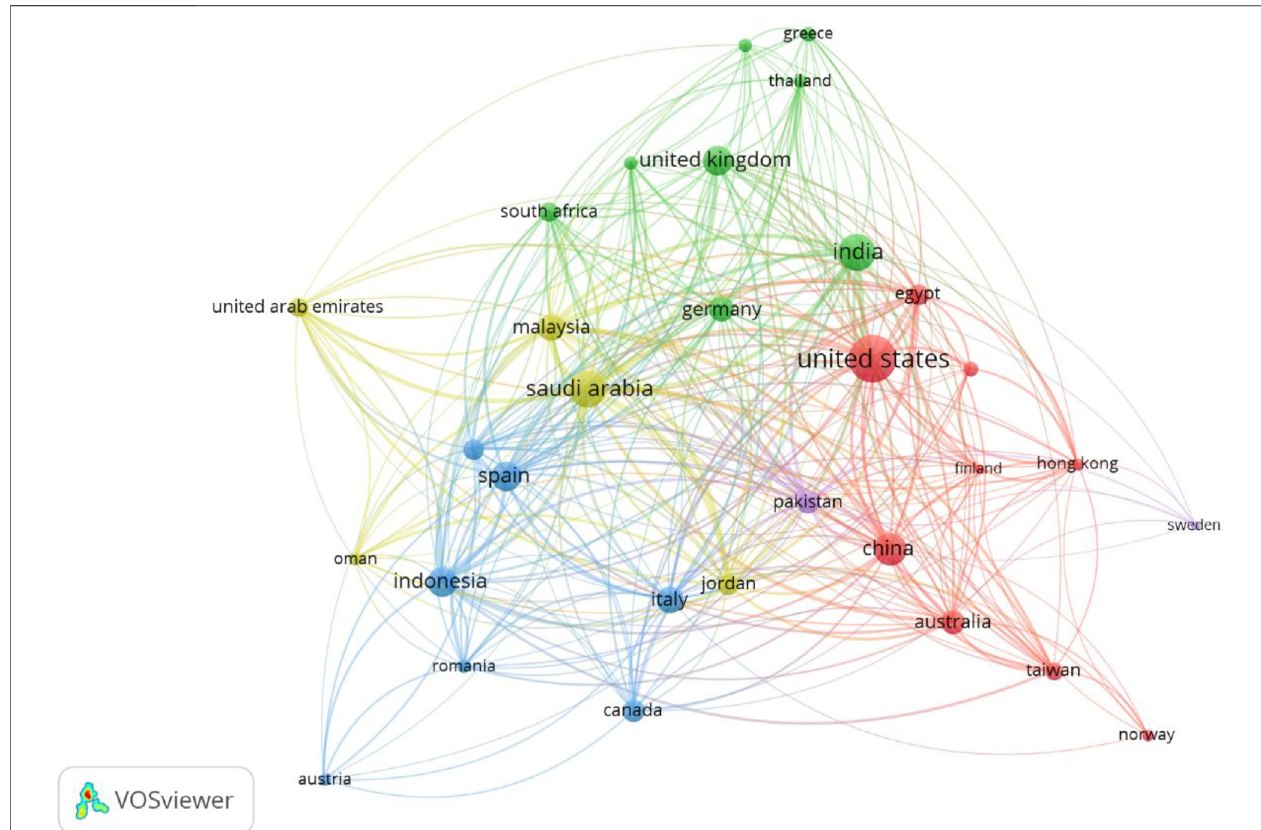
FIGURE 2 | Network map of co-authorship of countries.